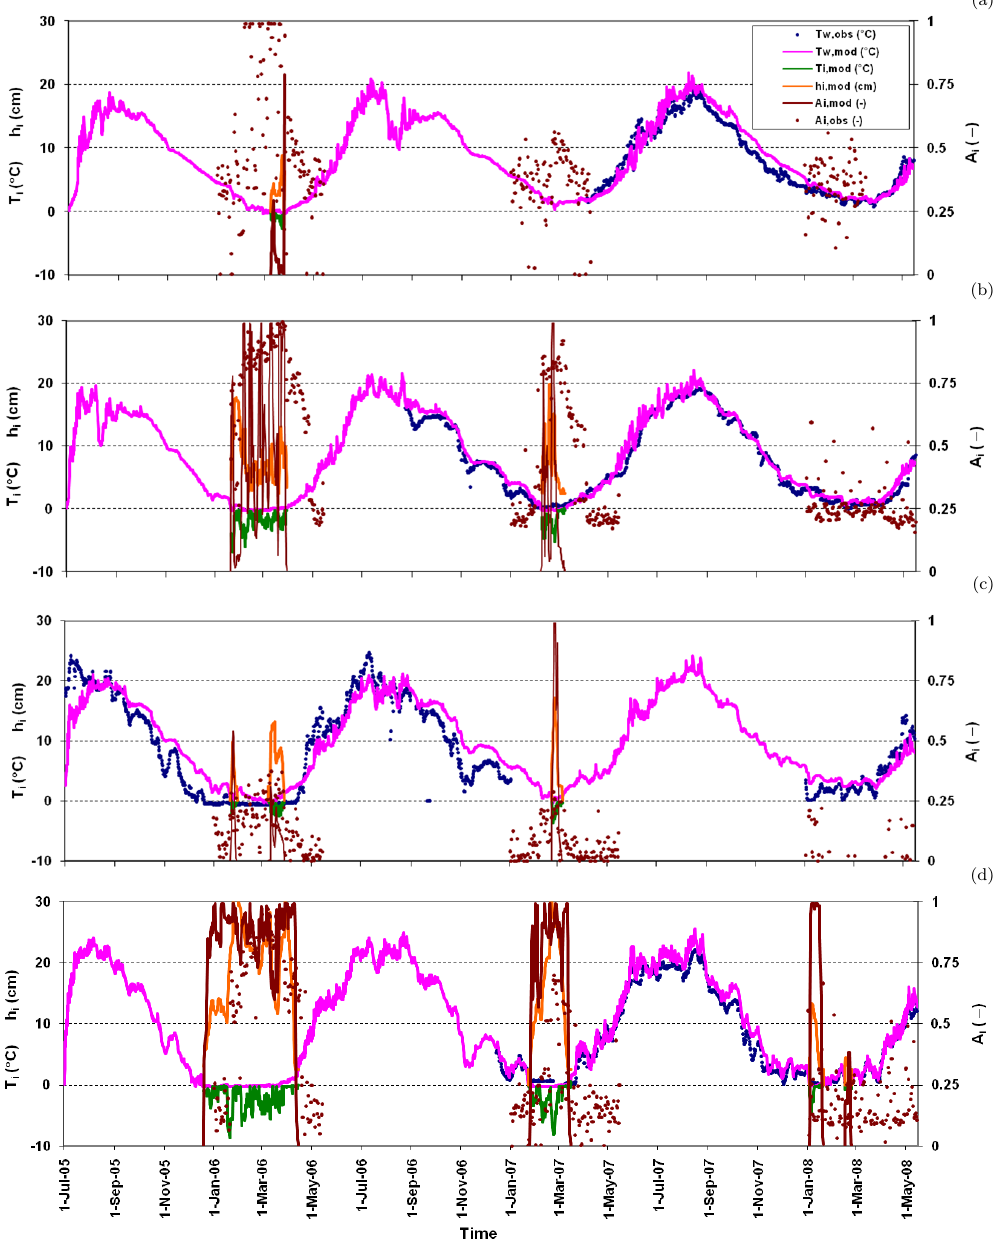
Fig. 2. Time series of the selected measured and modelled parameters at stations Muuga (a) , Sillam¨ae (b) , Soru (c) and P¨arnu (d) , see Table 2 and numbered sites in Fig. 1. The measured surface water temperatures were supplied by the BOOS data. The observed ice concentrations were extracted from the NSIDC